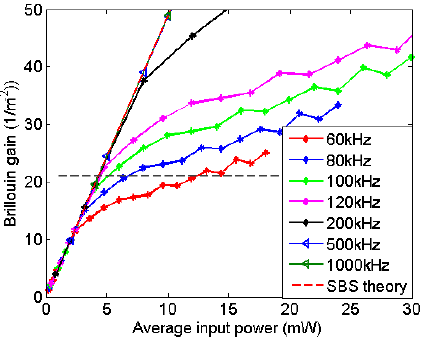
Figure 5. The Brillouin gain versus the average input power with different repetition rates.